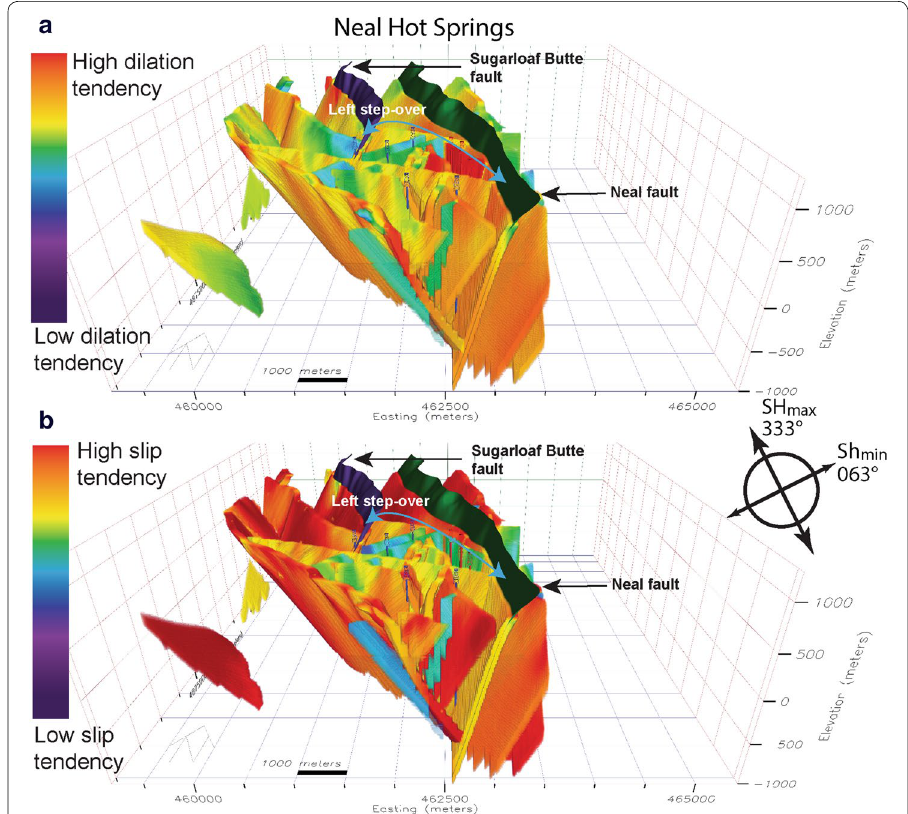
Fig. 10 Dilation ( a ) and slip ( b ) tendencies calculated for the 3D mapped fault system at Neal Hot Springs. Warm colors represent a high potential for that part of a fault zone to be critically stressed and are therefore more likely to conduct fluids relative to other fault segments. Cool colors indicate that the resolved stresses on the fault surface are relatively low, and therefore the fault is not critically stressed and has less potential to conduct fluids. The modeled horizontal stress field, based on inversion of fault kinematic data, is shown; the maximum stress is